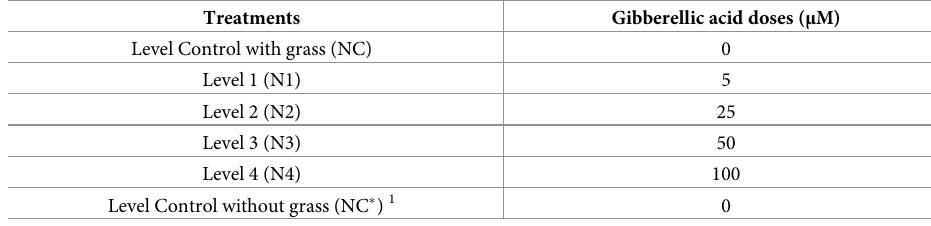
Table 1. Treatment with the application of GA 3